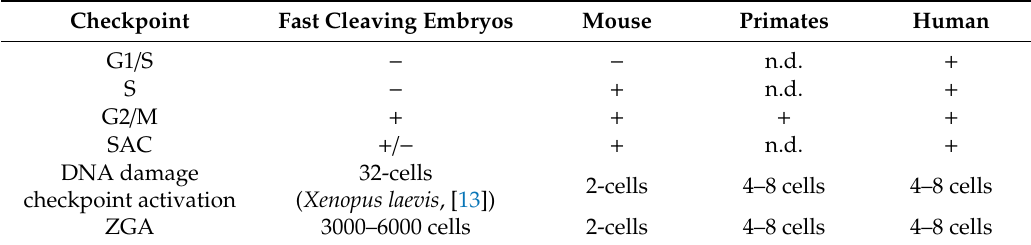
Table 1. Genome integrity checkpoint and zygotic genome activation during early embryogenesis. The table summarizes the presence ( + ) or absence ( − ) of the indicated genome integrity checkpoints observed in fast cleaving early embryos ( C. elegans , Drosophila , zebrafish, and Xenopus ), as well as in mouse and human embryos. n.d.: not determined; SAC: spindle assembly checkpoint. ZGA refers to the early waves of transcription occurring at MBT in Drosophila , zebrafish and Xenopus laevis . Checkpoint Fast Cleaving Embryos Mouse Primates Human G1 / S − − n.d. + S − + n.d. + G2 / M + + + + SAC +/ − + n.d. + DNA damage checkpoint activation